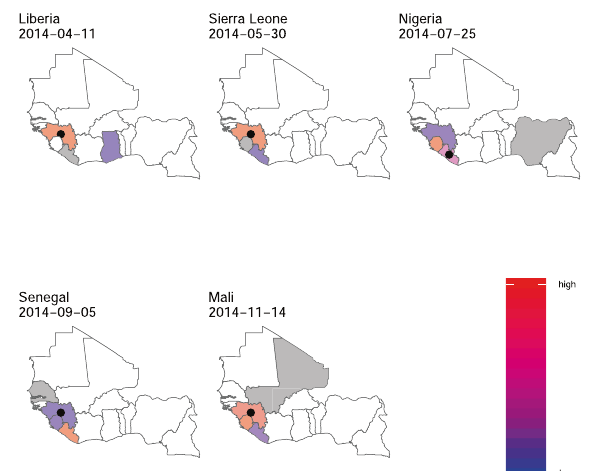
Fig. 3 Relative risk of importation of the epidemic. For each country with non-zero incidence, the fi gure shows the relative importation risk (see Methods). Since we forecasted every 7th day, the risk of importation was estimated using forecasts closest to and before the date of the fi rst case in that country reported in the data used. The date on which risk was estimated for each country is shown in the fi gure. Blue indicates low relative risk while deeper shades of red represent higher relative risk of acting as a source of importation. White is used to denote no risk. The estimates presented here use ProMED data with a 2 week calibration window. The country for which risk is estimated is shown in grey. The black circle represents the actual source of importation as retrospectively identi fi ed through epidemiological and genomic investigations. For each country, the fi gure shows only the risk of importation from other countries and does not show the risk of transmission within the